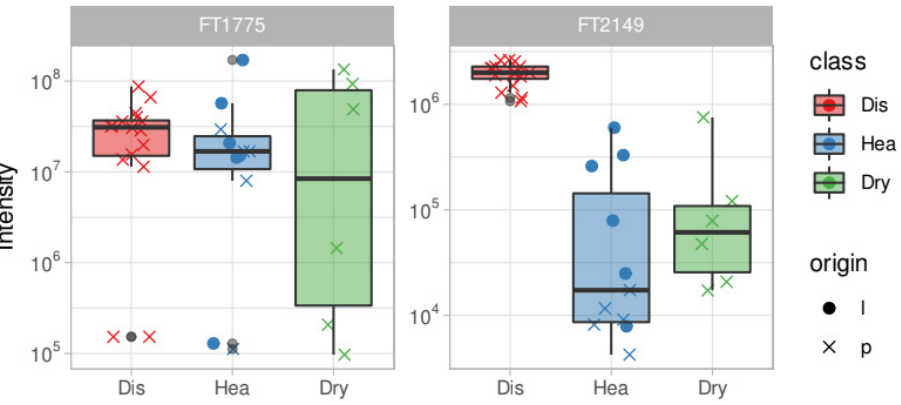
Figure 5. Boxplots for reported O.e species-specific markers Red boxes represent the diseased samples, blue boxes the healthy samples and green boxes the dried